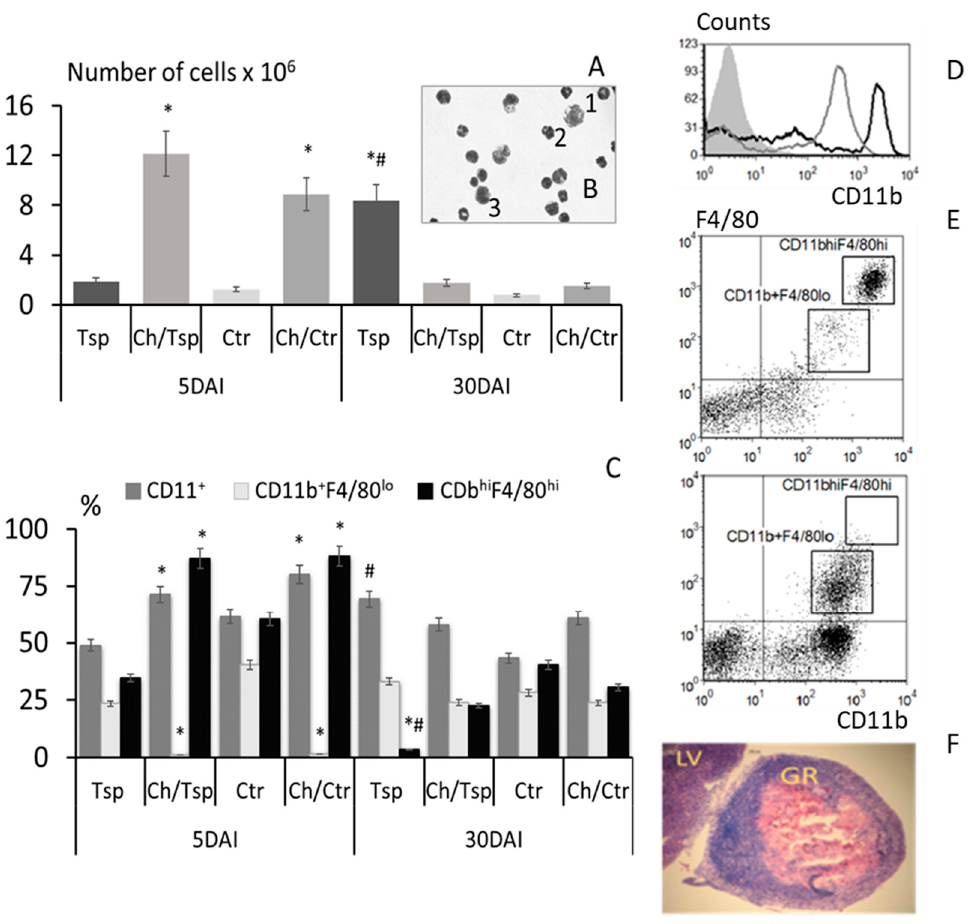
Figure 1. The cell response in the peritoneal cavity of mice injected intraperitoneally with chitosan and infected with T. spiralis five and 30 days after infection (DAI): ( A ) the number of cells; ( B ) the peritoneal cell glass smear from mice injected with chitosan then infected with T. spiralis (the smear being taken five days after infection). Giemsa stain; B 1: macrophage, B 2: neutrophil, B 3: monocyte; the percentage of myeloid cell populations: ( C ) CD11b + cells; CD11b + F4/80 hi —resident macrophages; CD11b + F4/80 lo —monocytes; ( D ) the number of cells identified by FACS: grey area—unstained cells, black line—after infection with T. spiralis ; grey line—after injection with chitosan and T. spiralis infection on day 5; ( E ) representative dot plot analysis of cell populations in mice on day 5 following T. spiralis infection ( upper ); and in those injected with chitosan ( lower ); ( F ) hematoxylin stained cross section of liver (LV) with chitosan filled granuloma (GR). (*) p < 0.05 chitosan vs. non treated; ( # ) p < 0.05 infected vs. control.